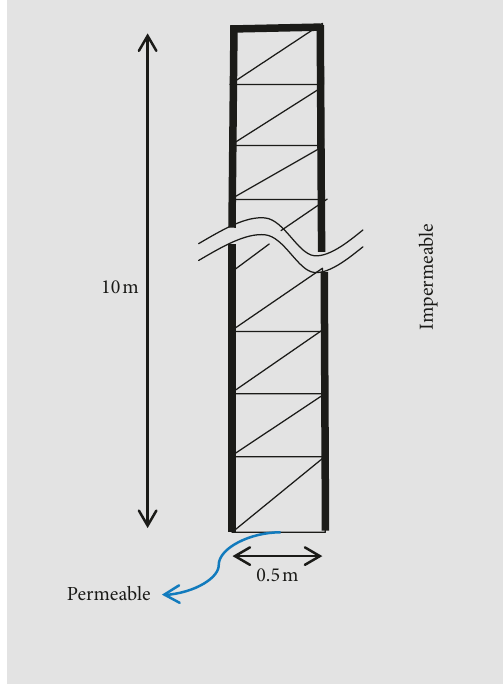
Figure 16: Finite element mesh configuration used in numerical simulation. The top and side boundaries are impermeable; bottom side is permeable.